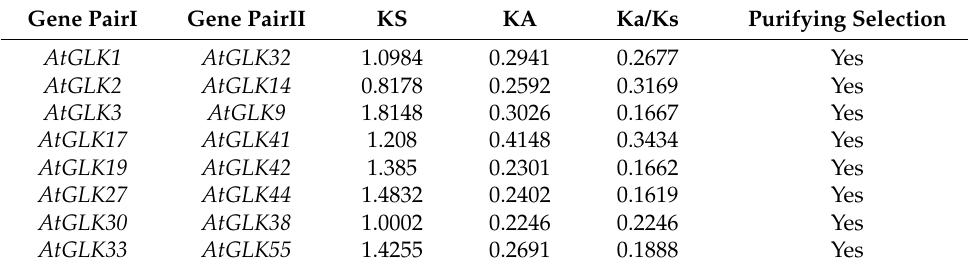
Table 1. The Ka, Ks, and Ka/Ks ratios of AtGLK gene pairs. Gene